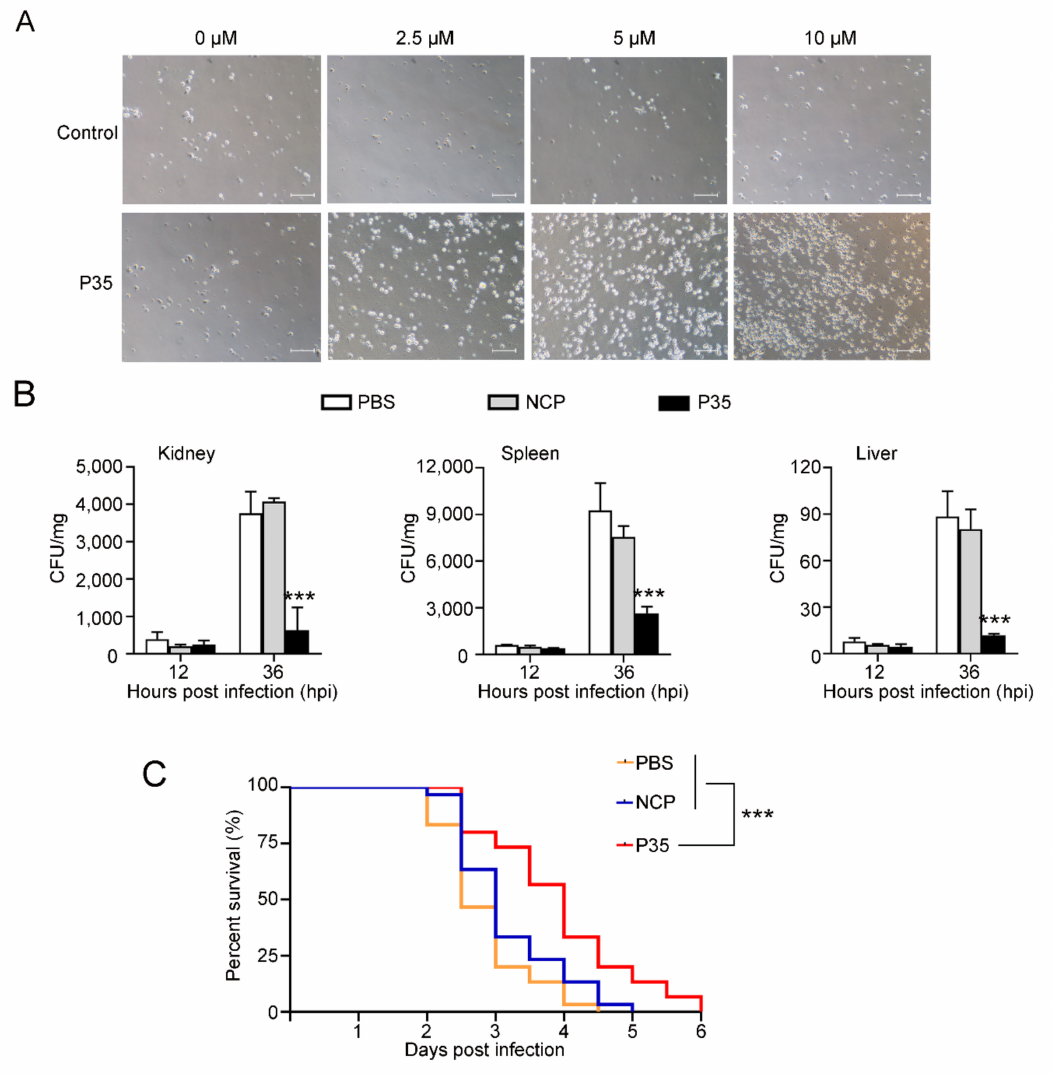
Figure 6. The effect of P35 on PBL migration and flounder immune defense. ( A ) The migration of flounder PBL in the presence of different doses of P35 or the negative control peptide was determined with a transwell migration assay. The migrated cells were observed with a microscope. Scale bar, 20 µ